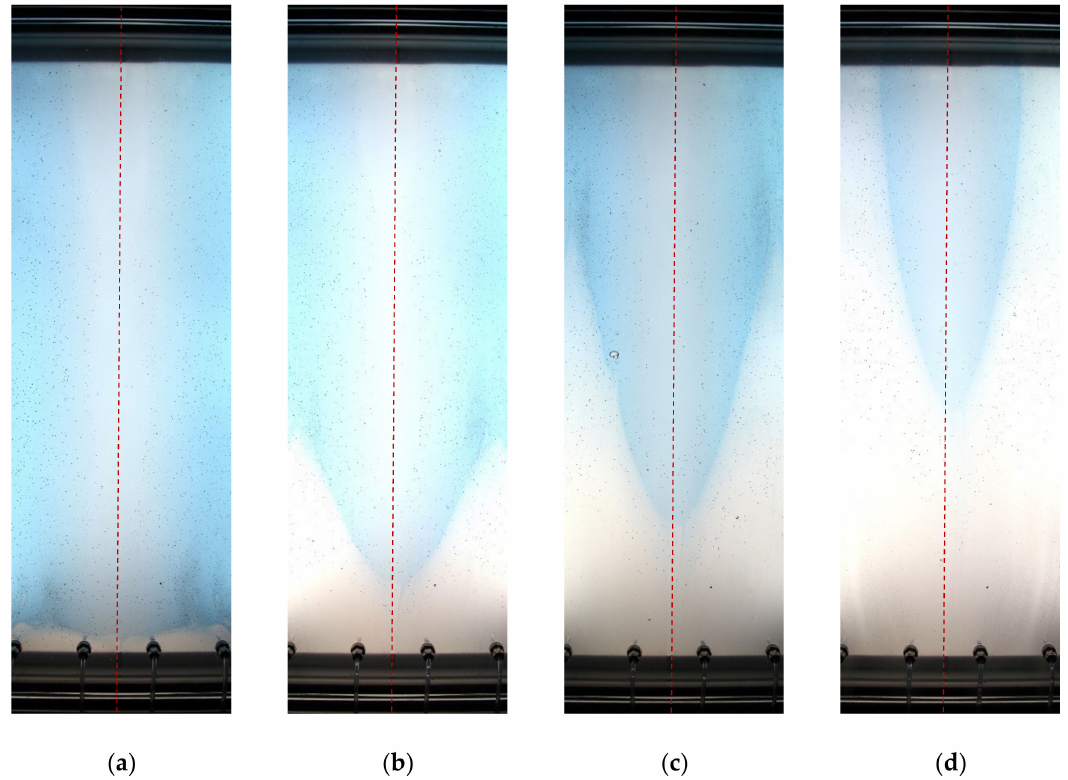
Figure 15. Snapshots of displacement flow in test no. 9: ( a ) t = 0 s; ( b ) t = 3 s; ( c ) t = 5 s; ( d ) t = 8 s.